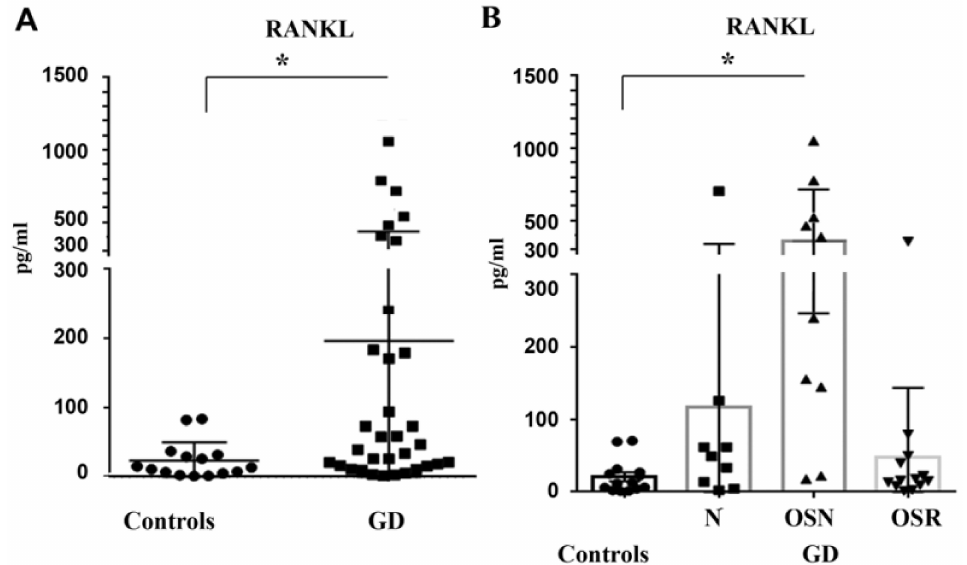
Figure 2. Plasma RANKL level. ( A ) RANKL levels, control vs. GD. Statistical analysis using un- paired t -test and F test to compare variance demonstrated a significant difference between control (mean 20 ± 5.8, n = 15) and GD cohorts (mean 166 ± 67.9, n = 33). * p < 0.05. ( B ) RANKL concentra- tions in control subjects and GD with no bone complication (N, mean 117 ± 74), osteopenia (OSN, mean 362 ± 118), and osteoporosis (OSR, mean 49 ± 26). * p < 0.05 ANOVA test, Tukey’s multiple comparisons test control vs. OSN and control vs.